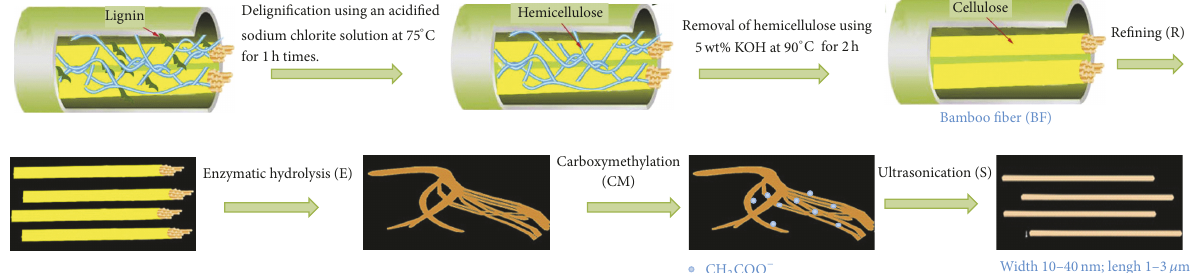
Figure 2: The individualization of bamboo fiber nanofibers from bamboo powders with typical laboratory-scale ultrasonication apparatus under neutral